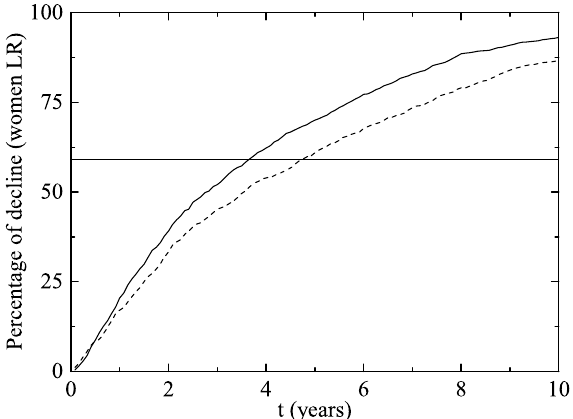
Figure 3. Percentage of decline of women aged 14–26 infected of LR HPV 6 and/or 11 (and consequently of GW) after the implementation of the vaccination program in both scenarios (Scenario 1: solid line and Scenario 2: dotted line). The horizontal line represents the percentage of decline in Australian women wart cases after two